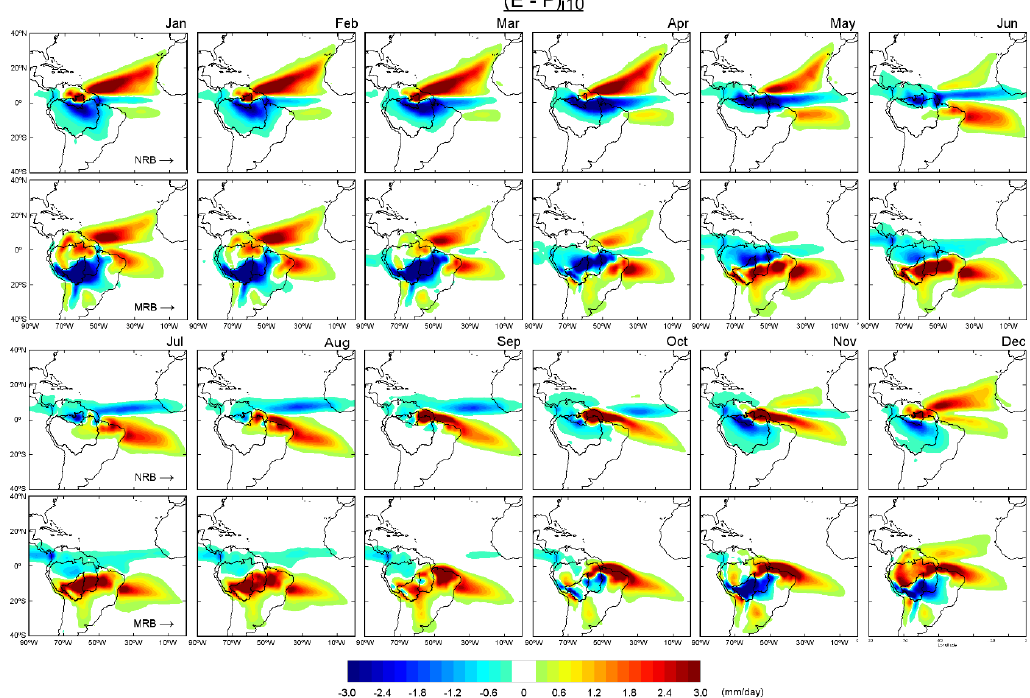
Figure 4. Monthly ( E − P ) i10 patterns for the NRB and MRB based on the backward in time experiment. Period: